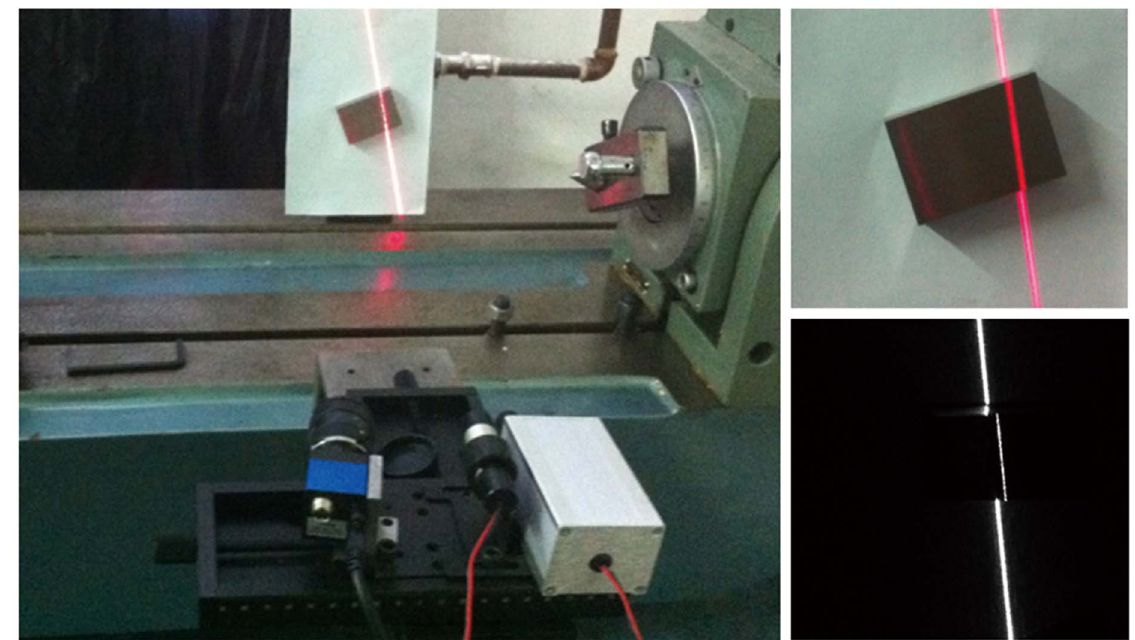
Figure 13. The imaging of gauge block.